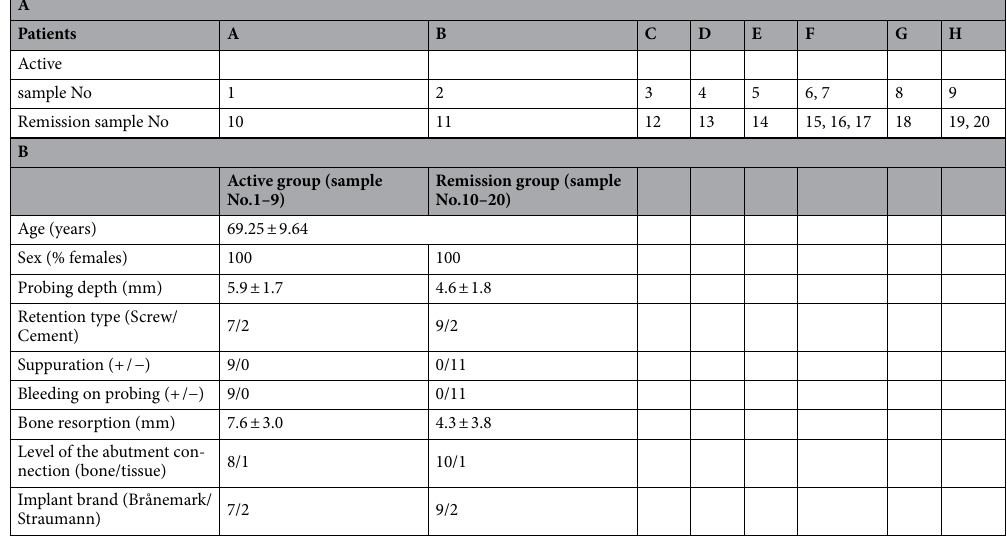
Table 1. Clinical information of